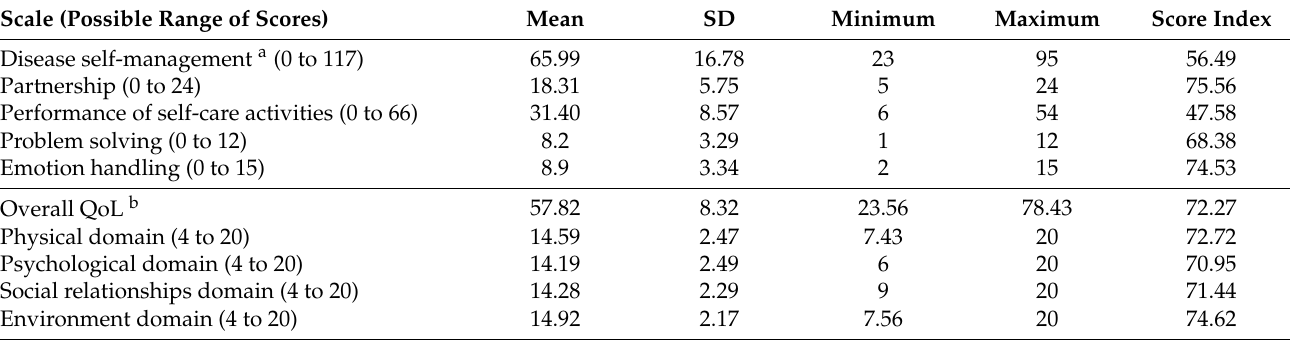
Table 3. Chronic disease self-management and quality of life in the older adults ( n =